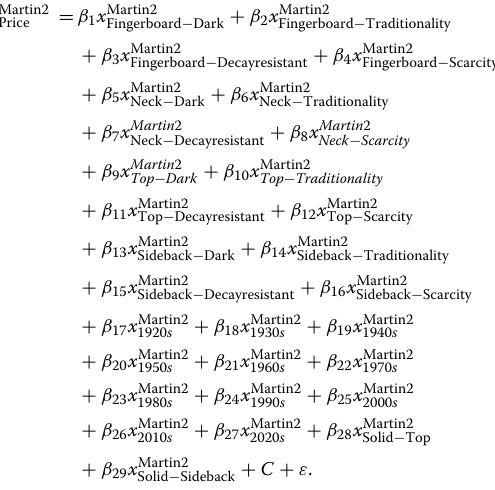
Table 4 Results of multiple regression analysis for